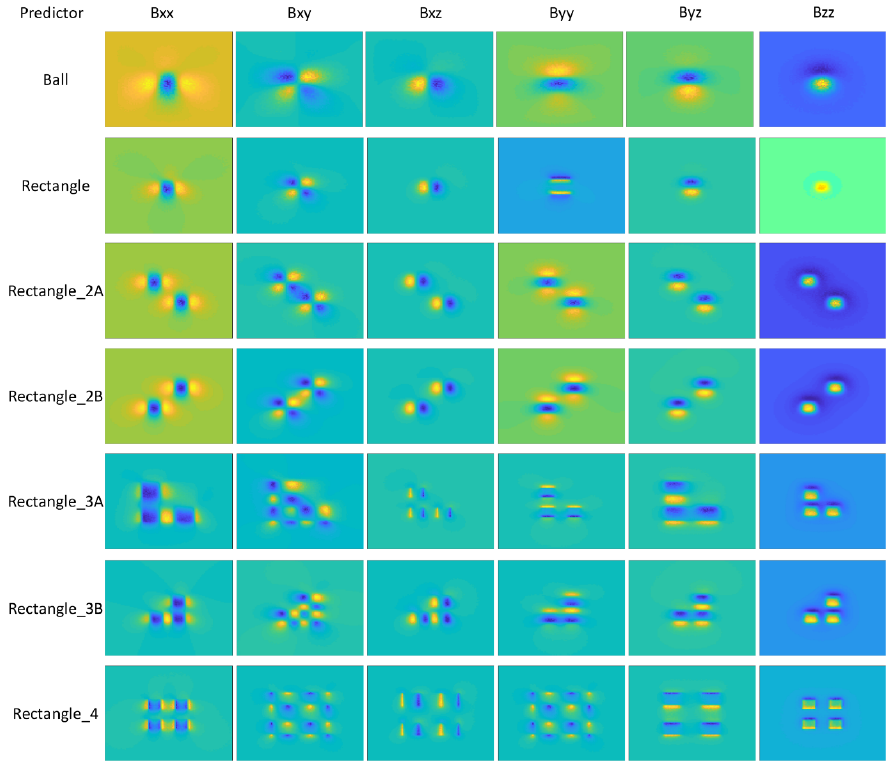
Figure 5. 2D images of seven models of MGT components.